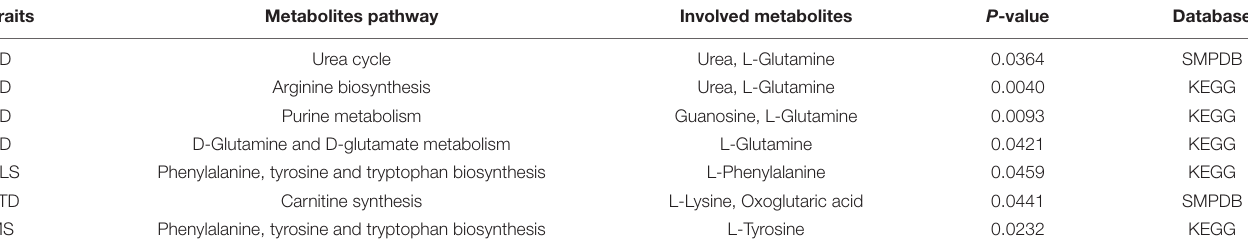
TABLE 4 | Significant metabolic pathways involved in the five neurodegenerative diseases.